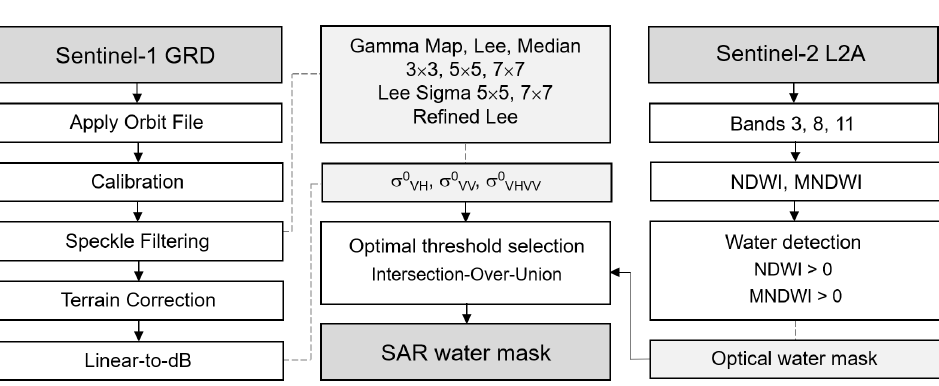
Figure 2. Optimal threshold selection algorithm